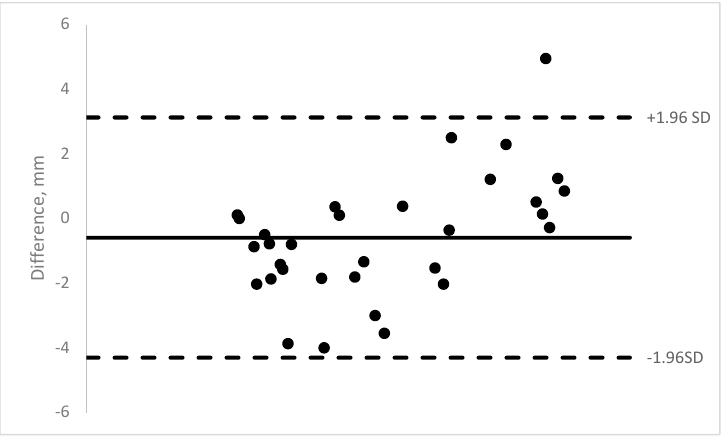
Figure 6. Visante Bland–Altman plot of intra-operative measurements versus OCT measurement.